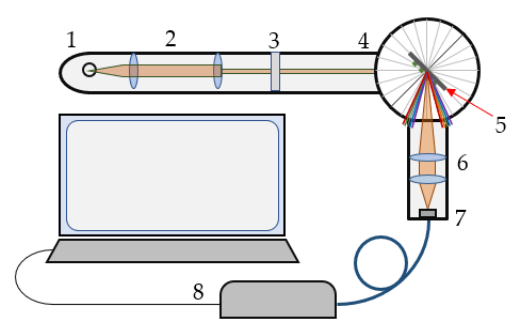
Figure 2. Optical set-up: 1 — tungsten lamp, 2 — collimator, 3 — polarizer, 4 — goniometer, 5 — biochip, 6,7 — objectives, and 8 — spectrometer .